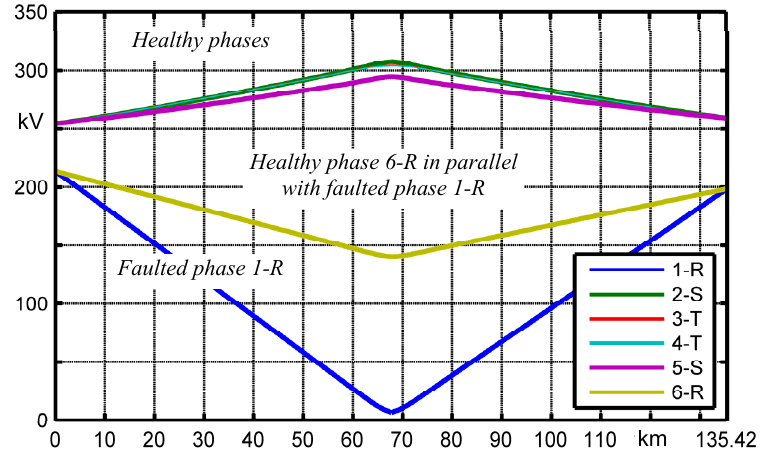
Figure 16. Line-to-earth voltage magnitudes along the